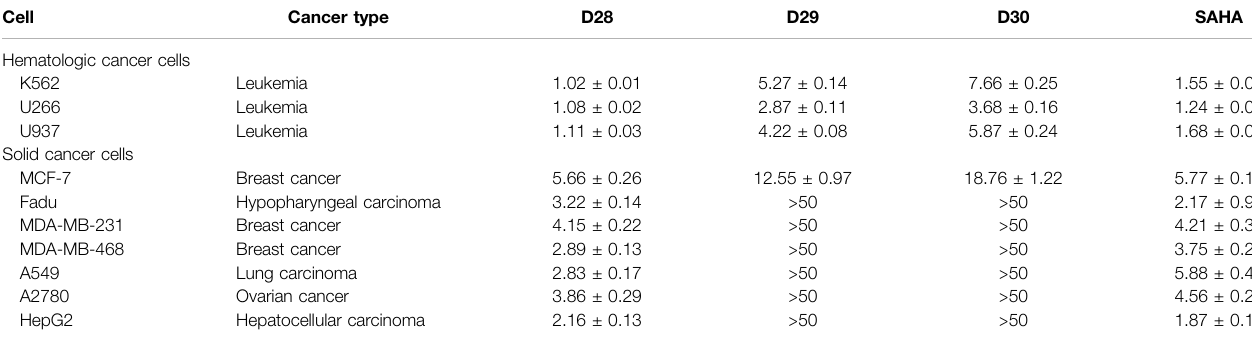
TABLE 3 | Antiproliferative activities of representative molecules against various cancer cell lines (IC Cell